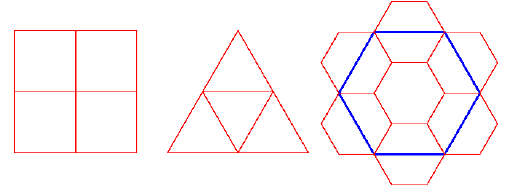
Figure 8. Regular cell division